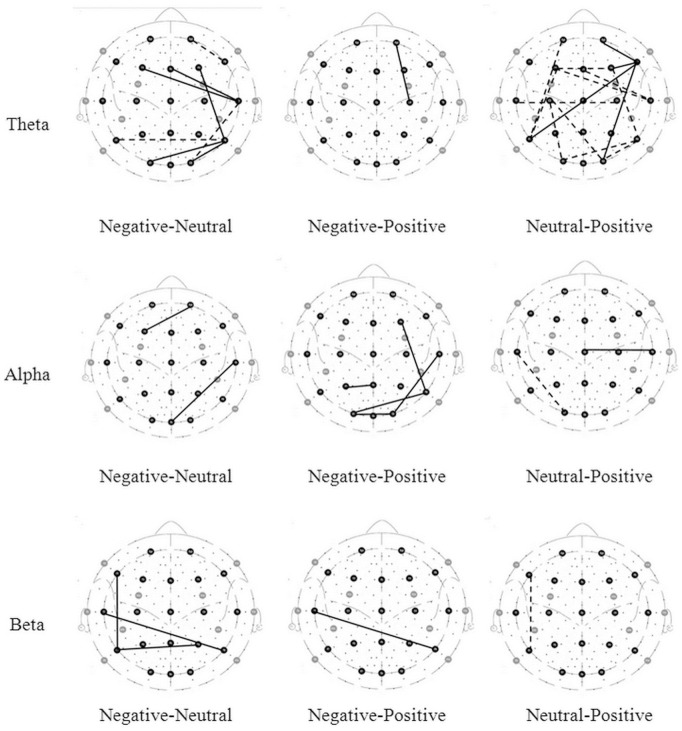
Brain maps of coherence.The lines connecting electrode sites indicate significant higher (solid) and lower (dashed) of coherence values for condition listed on left site.